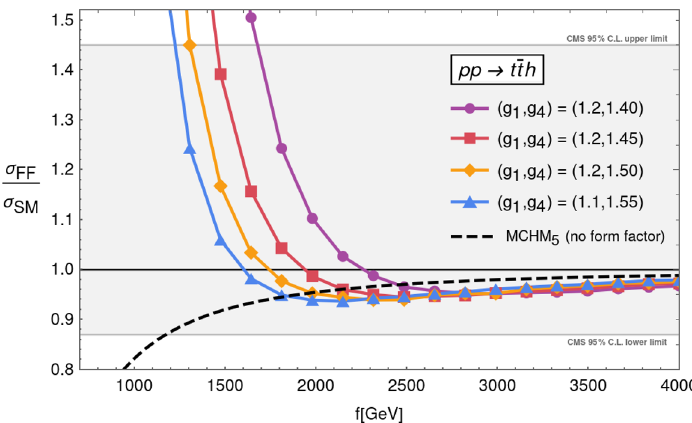
Figure 10 . Normalized tth cross-section of the top-Yukawa form factor model as a function of f √ for the MCHM 5 . Parton-level signal simulation done in MadGraph5_aMC@NLO at s = 14 TeV. The plot is normalized to the SM prediction. The CHM without momentum dependence has an overall suppression of vertices that goes with κ 5 . The dashed black curve depicts such suppression. By ξ turning on the form factor effects, we get an enhancement due to the analytic structure of their expressions. Fixing the parameters by theory constraints leaves us with a single mass dependence, which is varied to produce the different curves shown. All curves respect the bounds from direct resonance searches, and the gray band is the CMS 95% confidence level bound on the experimental cross-section over SM prediction